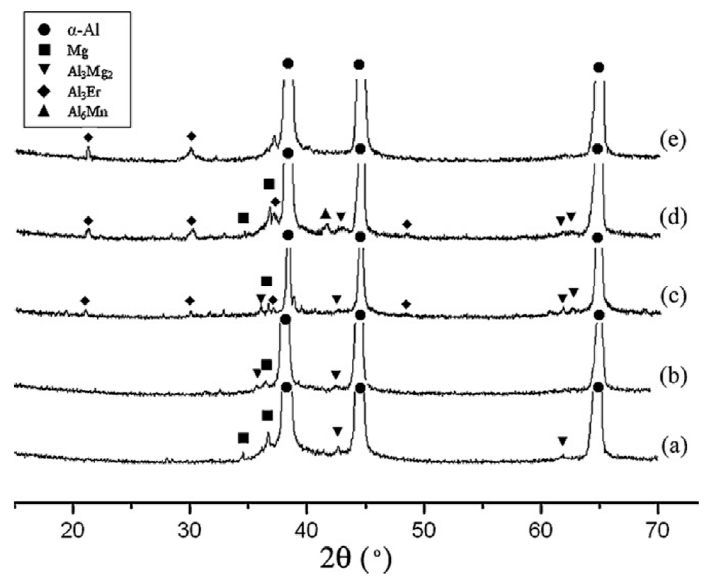
Figure 8. XRD di ff raction pa tt erns of as-cast alloys [27]: ( a ) 0Er, ( b ) 0.2 wt.%Er, ( c ) 0.4 wt.%Er, ( d ) 0.6 wt.%Er, ( e ) homogenized with 0.4 wt.%Er. Reprinted with permission from [27], 2009, Elsevier.